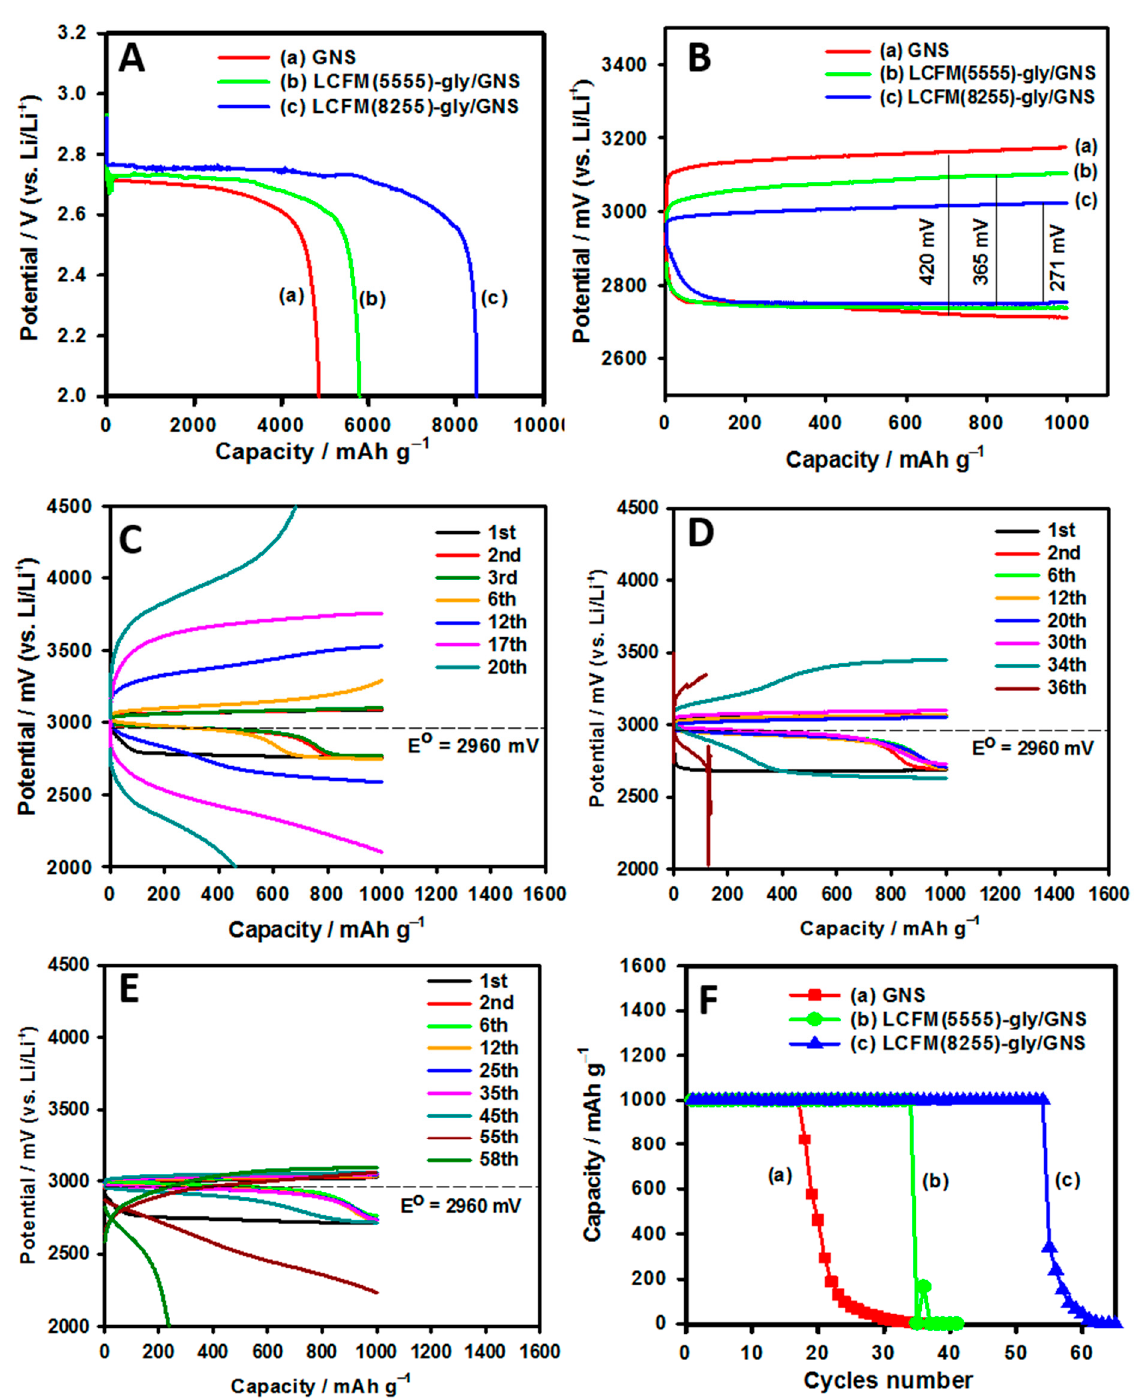
Figure 7. ( A ) Initial discharge curves of ( a ) GNS, ( b ) LCFM(5555)-gly/GNS and ( c ) LCFM(8255)-gly/GNS-based Li-O 2 cells at a current density of 100 mA g − 1 . Discharge–charge curves of ( a ) GNS, ( b ) LCFM(5555)-gly/GNS and ( c ) LCFM(8255)- gly/GNS-based Li-O 2 cells for ( B ) overpotential difference and ( C – E ) cycling stability analysis. ( F ) Cycle life of ( a ) GNS, ( b ) LCFM(5555)-gly/GNS and ( c ) LCFM(8255)-gly/GNS-based Li-O 2 cells. Current density: 100 mA g − 1 ; Limited discharge capacity: 1000 mAh g − 1 ; Electrolyte: 1 M LiTFSI-TEGDME + 0.5 M LiI.